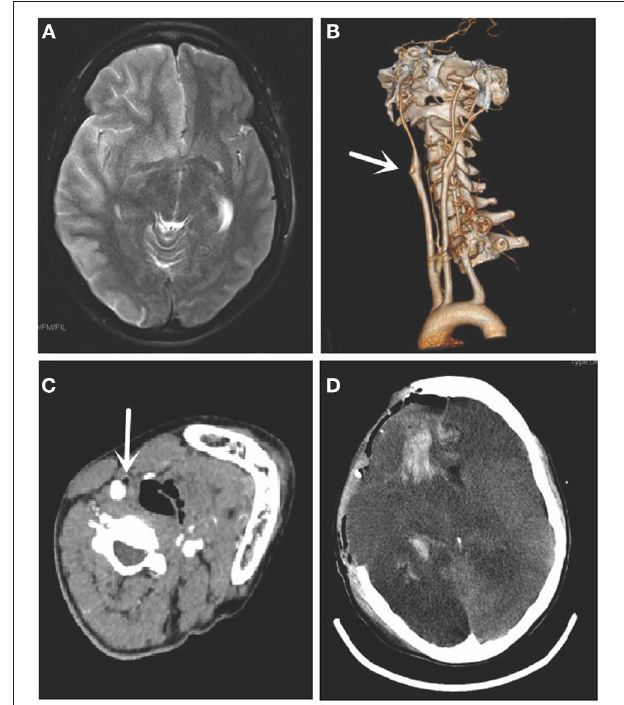
FIGURE 1 | Magnetic resonance imaging (MRI), cervical computed tomography angiography (CTA), and computed tomography (CT) of case 1. (A) The cranial MRI showed acute infarction in the territory of the right internal carotid artery. (B) CTA showed occlusion of the right external carotid artery (arrow). (C) Cross-section indicated fat emboli within the lumen of the right external carotid artery (arrow). (D) Cranial CT showed the right swelling hemisphere and incomplete skull after decompressive